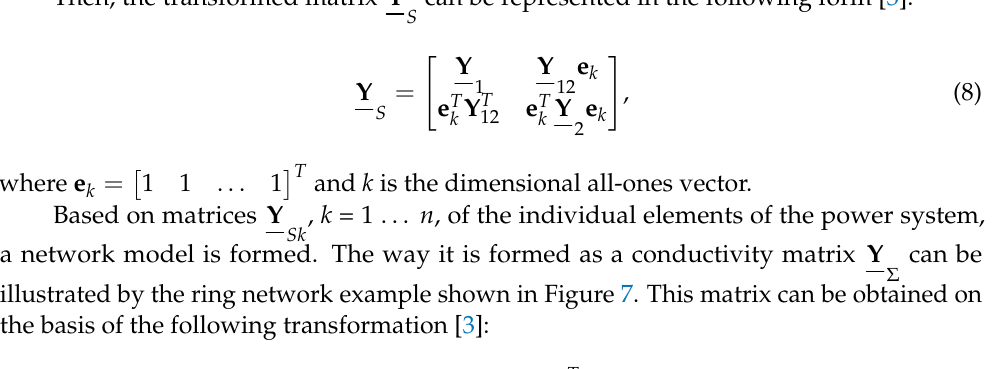
Figure 5. Original circuit of the power transmission line.